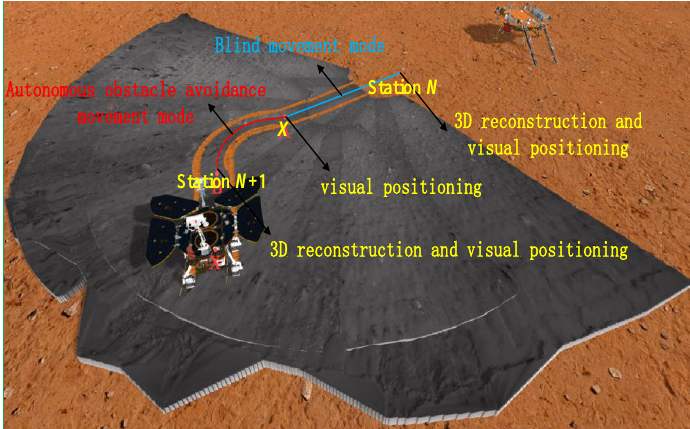
Figure 3. The schematic diagram of Zhurong’s station.